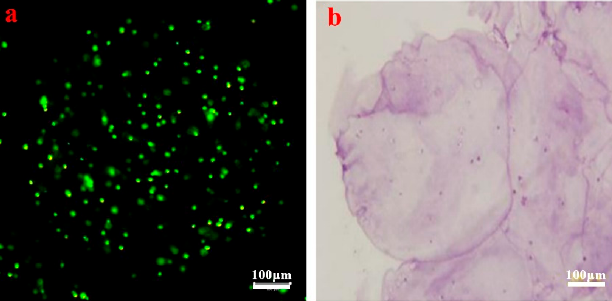
Figure 3. Confocal laser scanning microscopy (CLSM) image of artificial C5.18 cells managed by ( a ) acridine orange/ethidium bromide (AO/EB) staining and ( b ) hematoxylin and eosin (H&E) staining.